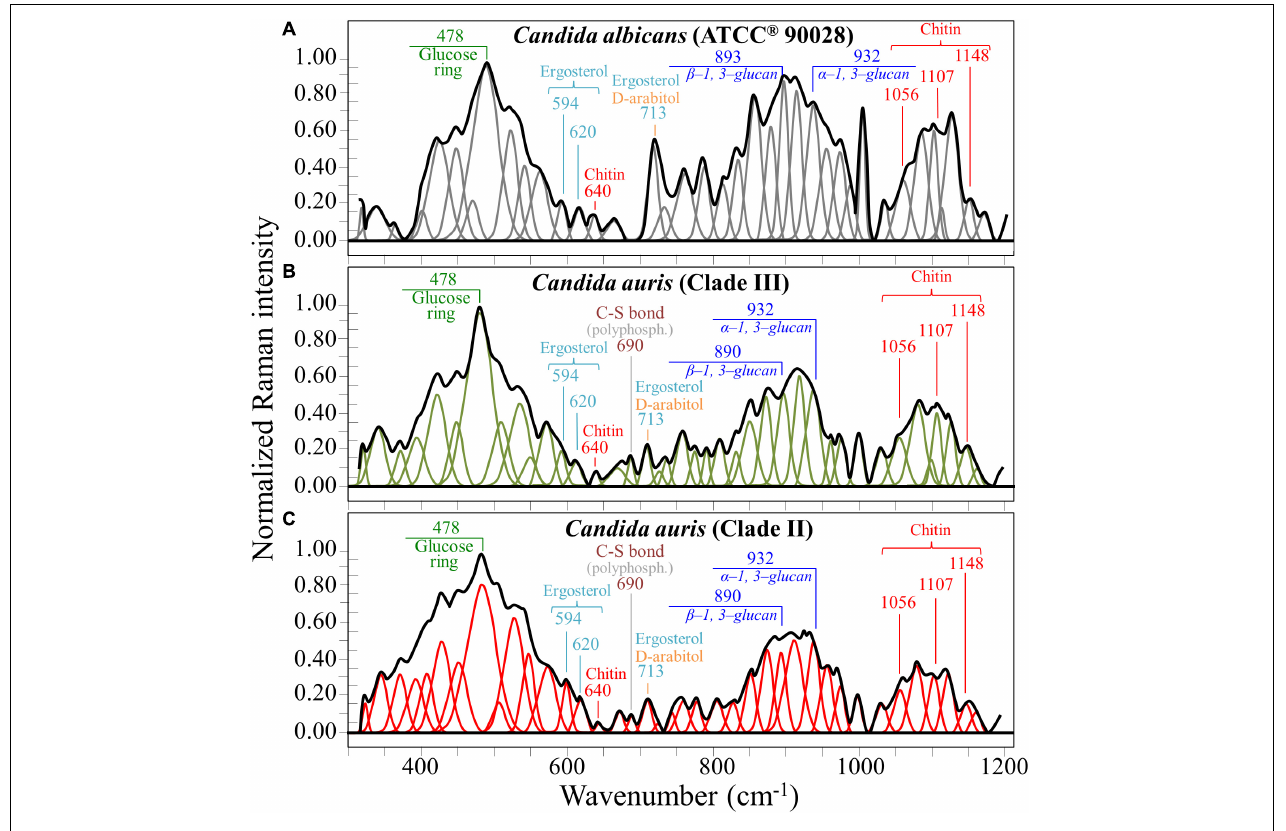
FIGURE 1 | Average Raman spectra of (A) C. albicans (ATCC R (cid:13) 90028), (B) C. auris (Clade III), and (C) C. auris (Clade II) in the wavenumber interval 300–1200 cm − 1 ; spectra are normalized to the glucose ring band at ∼ 478 cm − 1 and deconvoluted into Voigtian sub-bands by means of the machine-learning algorithm described in section “Chemometric Analysis.” The wavenumbers and the assignments of the main bands discussed in the text are given with labels in